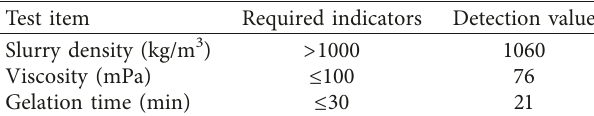
Table 2: The major performance parameters of the mixed